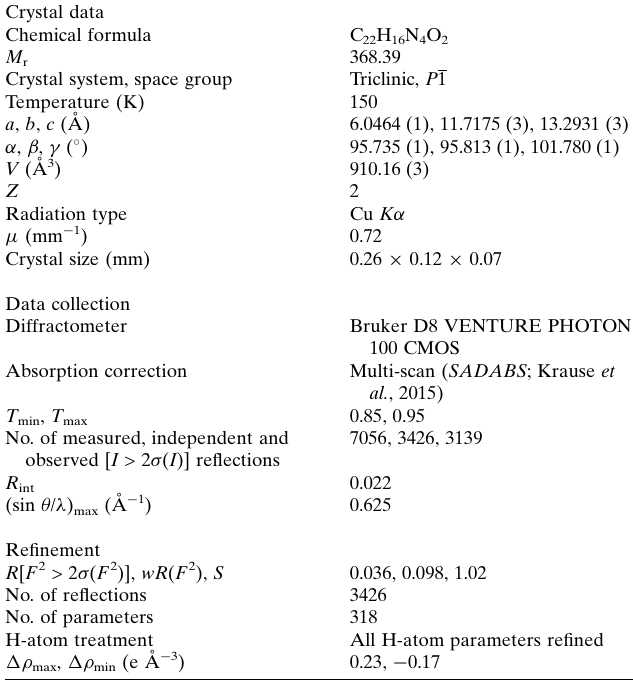
Table 5 Experimental